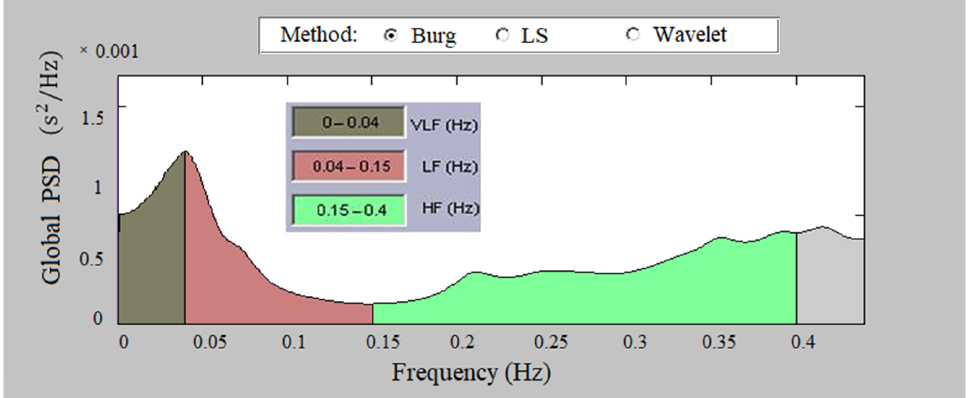
Figure 10. Global PSD of heart failure, Burg method.